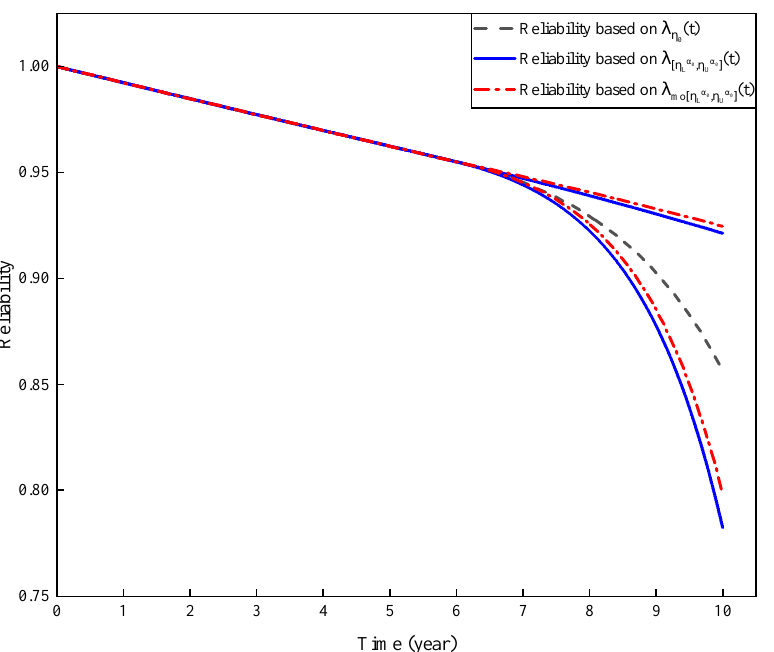
Figure 5. Comparison of reliability curves of the pressure vessel safety instrument system models before and after modification.